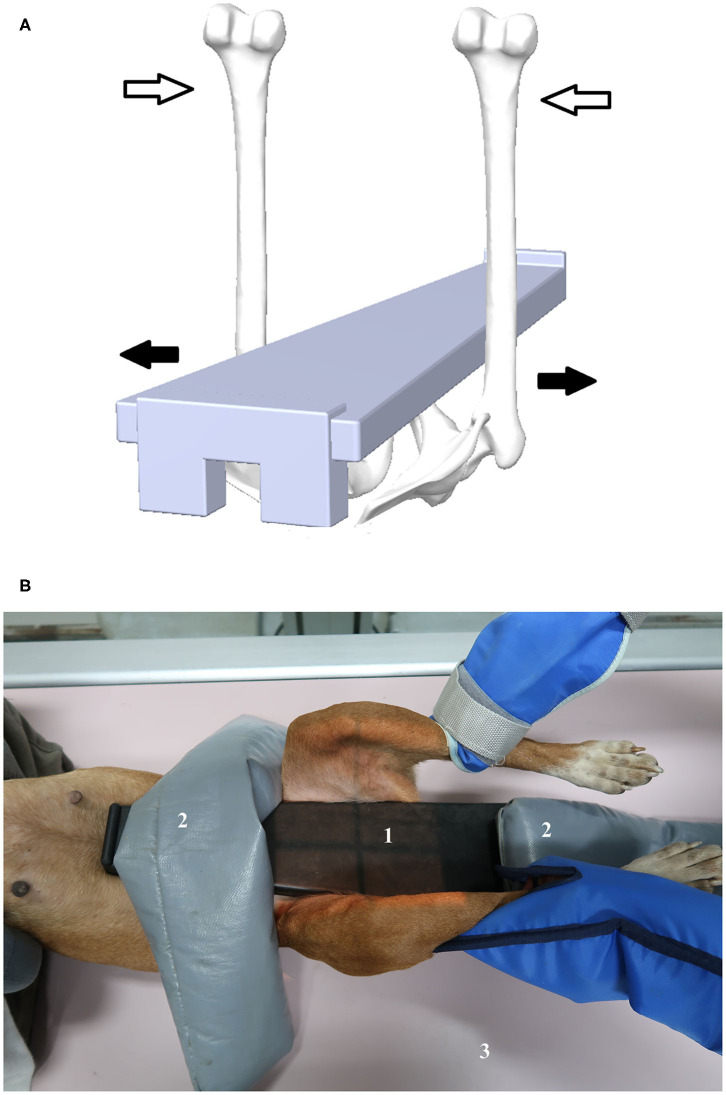
The Dis-UTAD is a modified Vezzoni distension device. (A) Illustration outlining the rear view of the dog and the Dis-UTAD. The open arrows represent the medial force exerted by the examiner, pushing the femurs against the distractor, and the full arrows represent the resulting hip distraction force. (B) Dis-UTAD positioned on the animal, fixed by the support of two sandbags. 1, Dis-UTAD; 2, sandbags; 3, X-ray table.